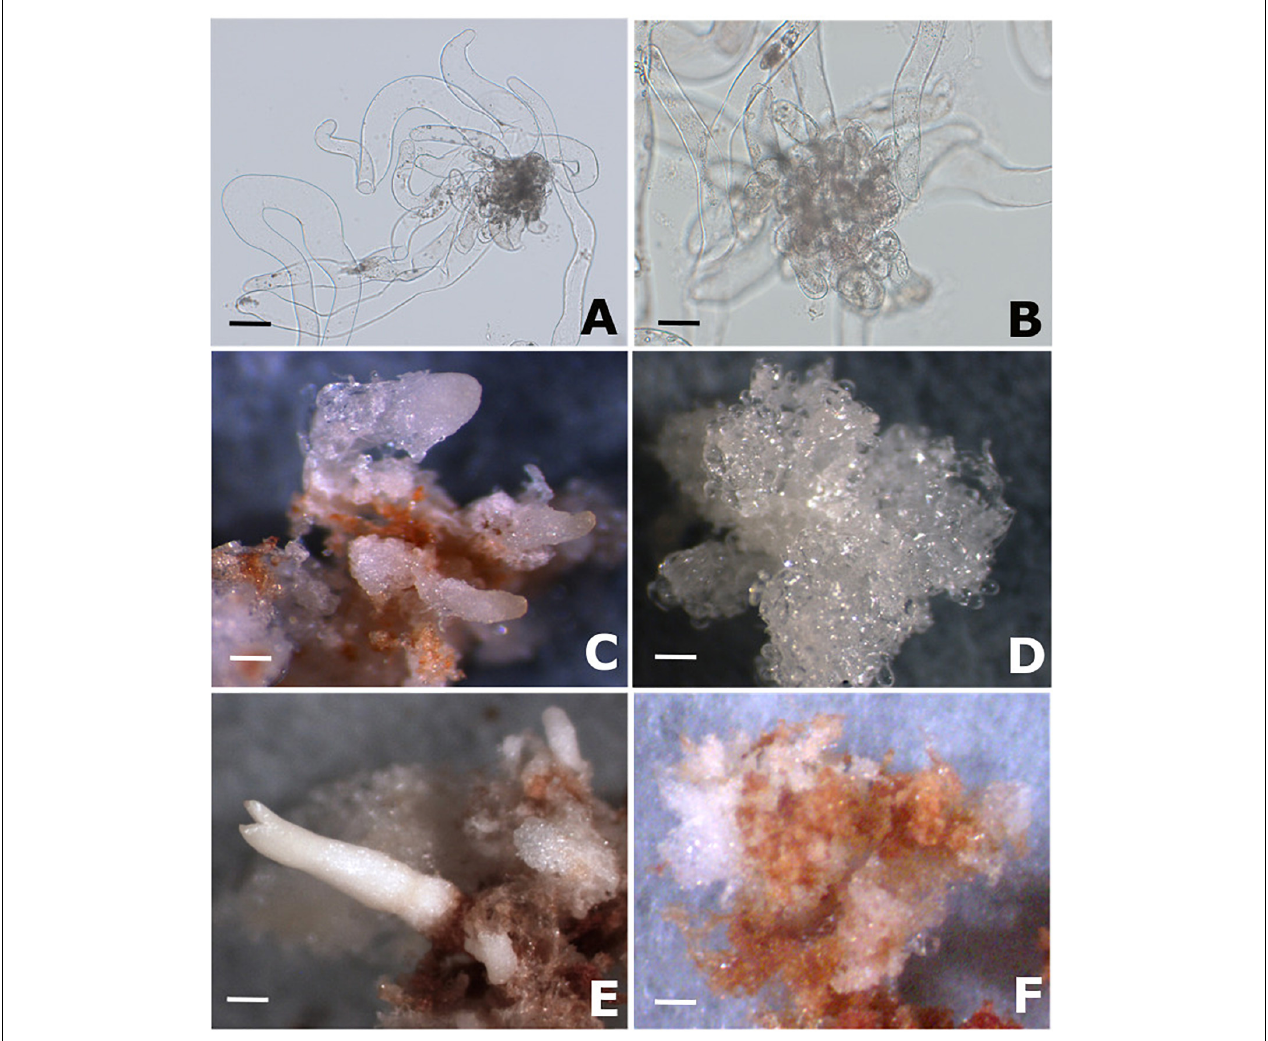
FIGURE 1 | PEMs proliferation and somatic embryo formation in Brazilian pine. (A) Morphology of cell line Y1 (responsive to maturation promoters) after 14 of proliferation on semi-solid MSG medium free of growth regulators. (B) Morphology of cell line B2 (blocked to the differentiation of somatic embryos) after 14 of proliferation on semi-solid MSG medium free of growth regulators. (C) Development of early somatic embryos in cell line Y1 after 2 months of cultivation on semi-solid MSG medium supplemented with 3% sucrose, 3% sorbitol, 120 µ M ABA and 1% Gelrite (maturation medium). (D) Proembryogenic mass of cell line B2 after 2 months of cultivation on maturation medium. (E) Somatic embryo of cotyledonary stage developed in cell line Y1 after 4 months of cultivation on maturation medium. (F) Proembryogenic mass of cell line B2 after 4 months of cultivation on maturation medium. Scale bar: 100 µ m (A,B) ; 2000 µ m (C–F) .